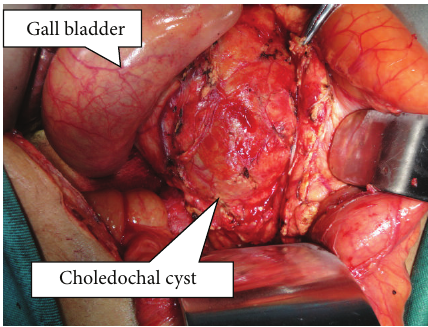
Figure 3: Intraoperative view of large choledochal cyst dissected out in patient 4 (Table 1).